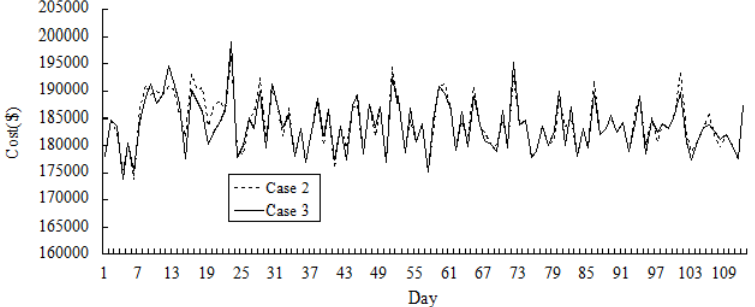
Figure 6. Comparative results of cost variation for Cases 2 and 3 (for 112 days).